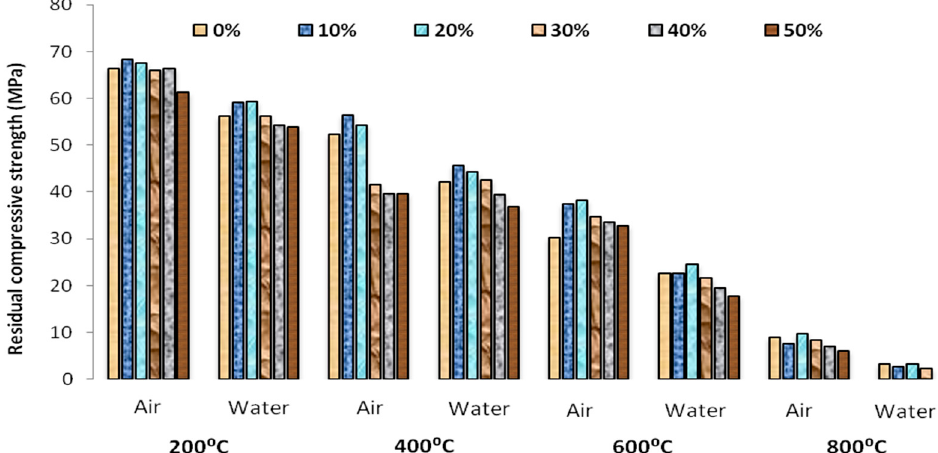
Figure 10. Compressive strength of SCGM at high temperature subjected to air and water cooling.